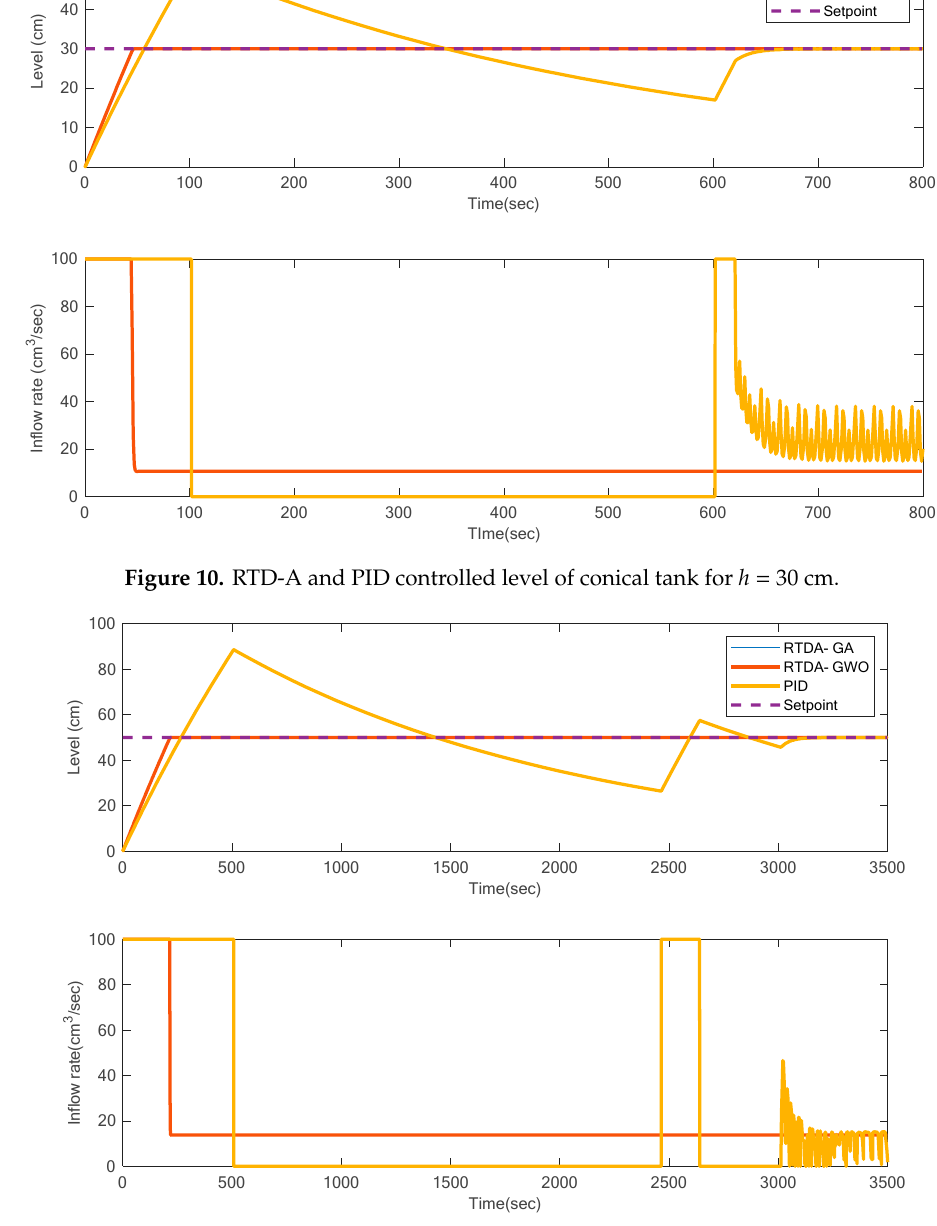
Figure 11. RTD-A and PID controlled level of conical tank for h = 50 cm.